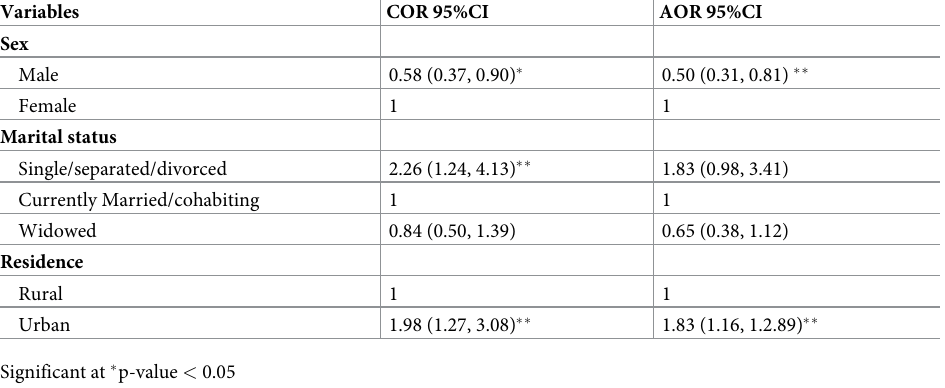
Table 4. Multivariate analysis of the correlates of personal care provided by older adult